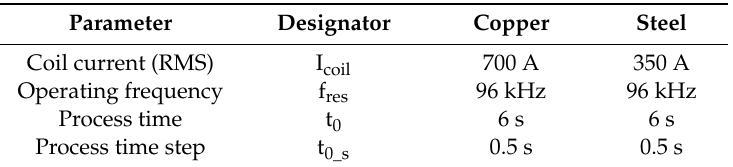
Table 1. Main simulation parameters.